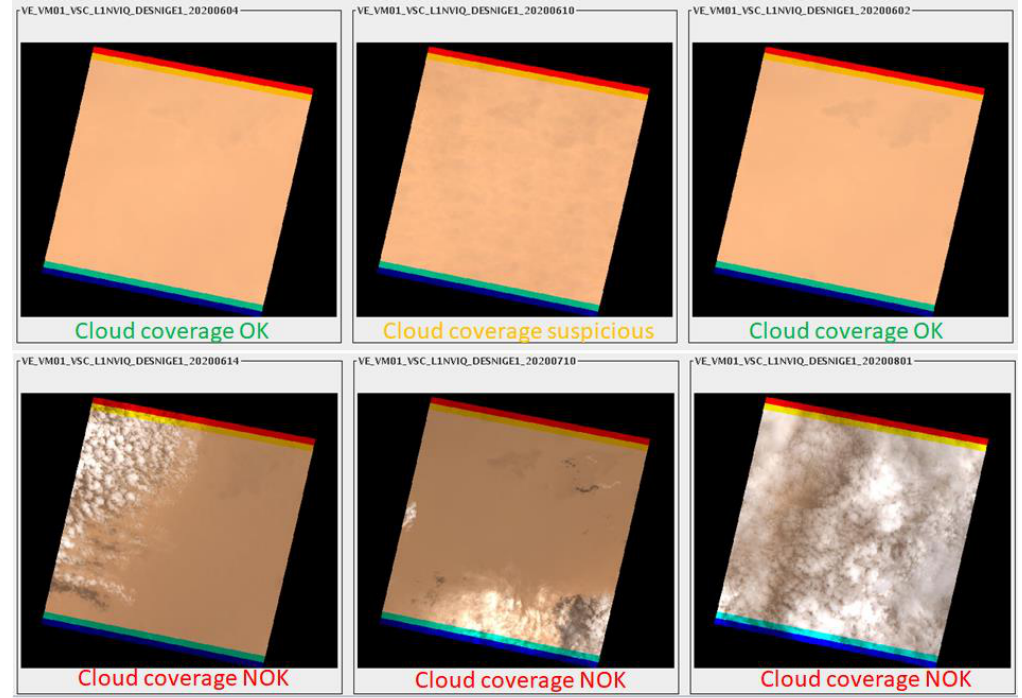
Figure 45. VEN μ S desert acquisitions, DESNIGE1 site, cloud coverage analysis. Figure 45. VEN µ S desert acquisitions, DESNIGE1 site, cloud coverage